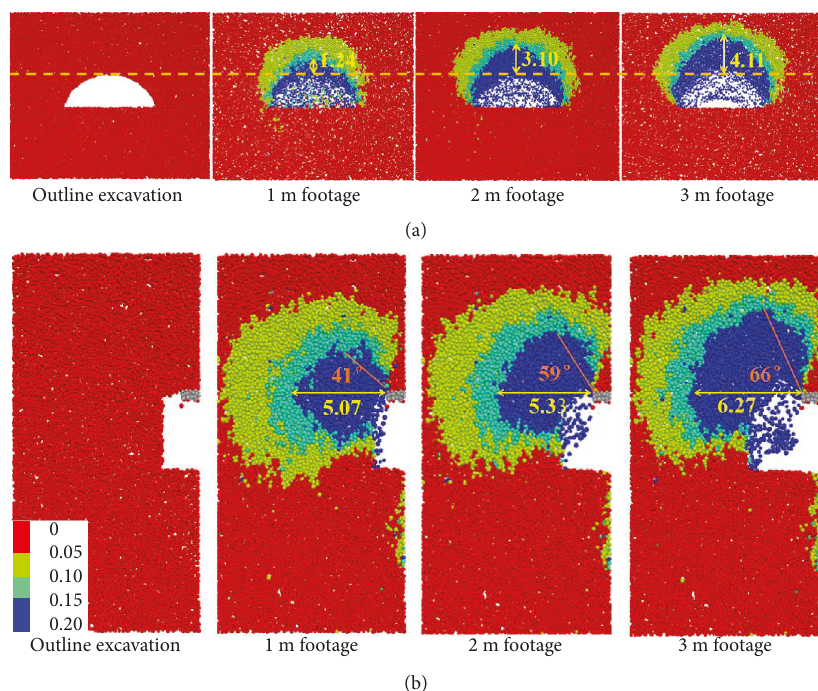
Figure 9: Displacement distribution law of the surrounding rock under different footages: (a) front view; (b) side view. 1.01.52.02.53.03.54.04.5